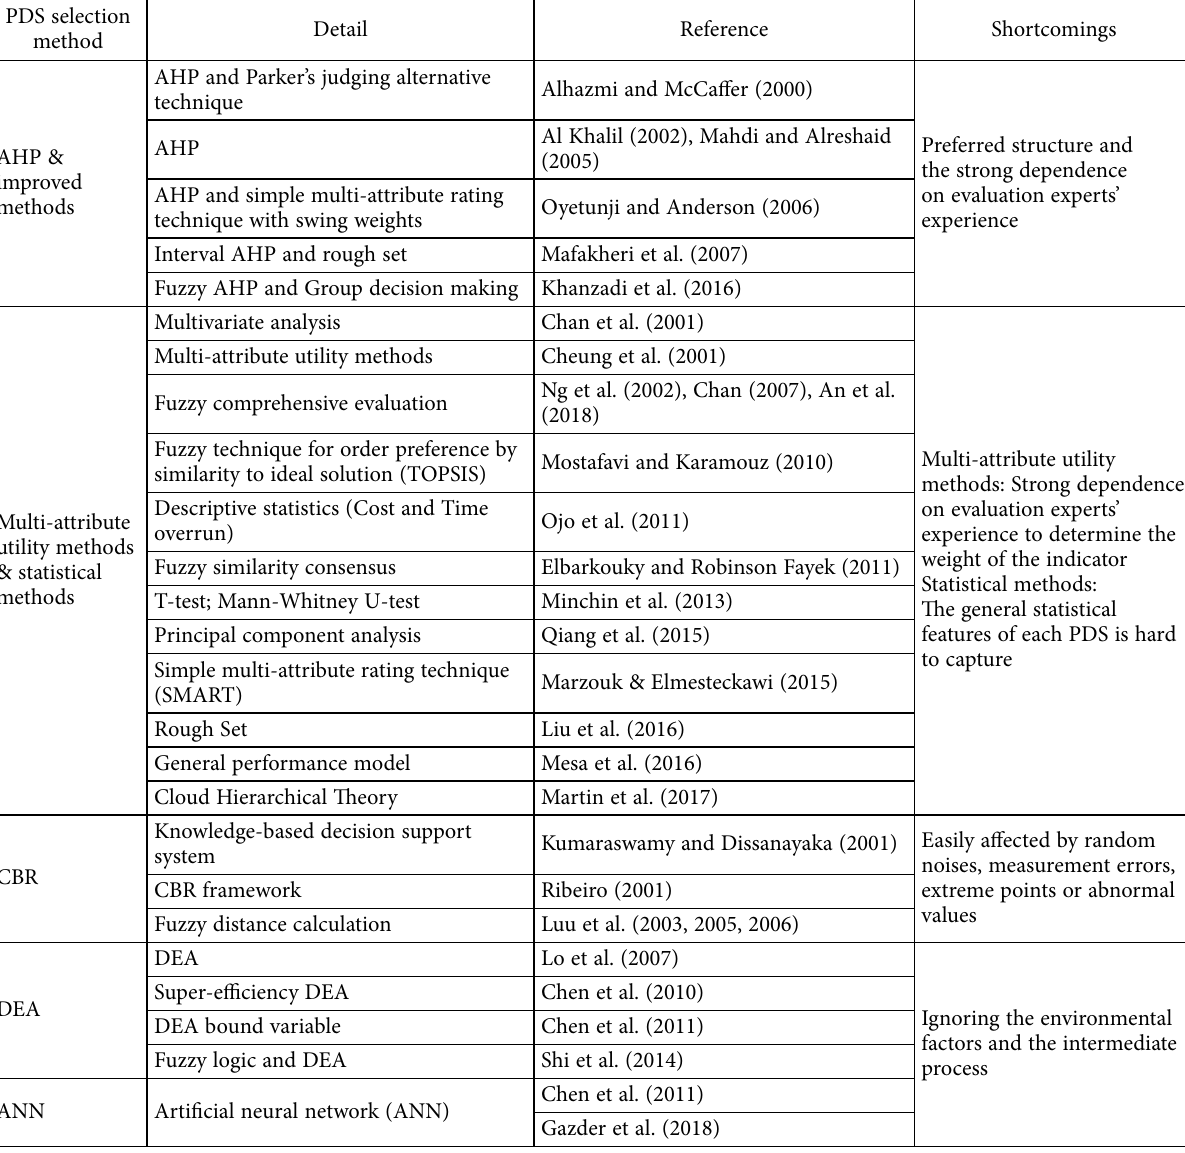
Table 1. Methods of PDS